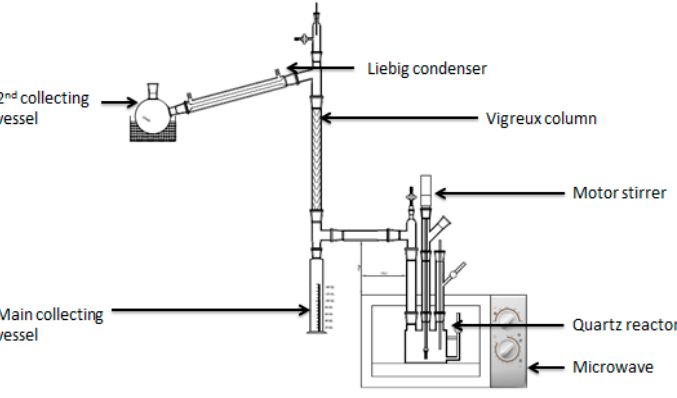
Figure 1. Schematic diagram of microwave pyrolysis apparatus.